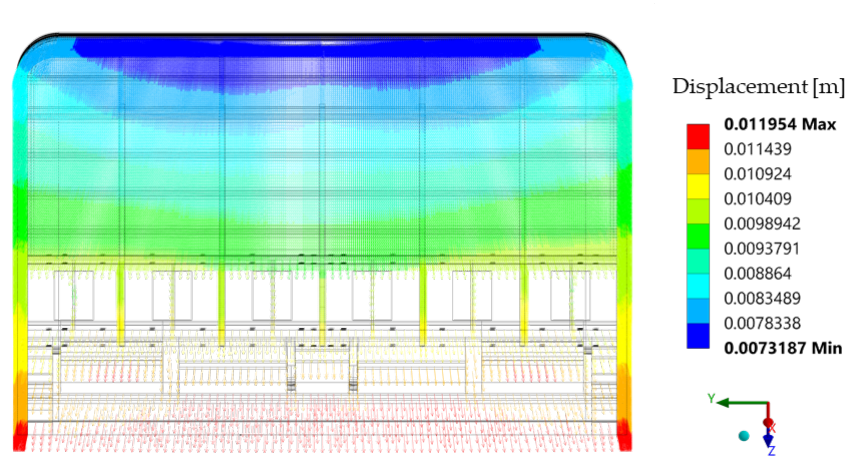
Figure 19. Displacement field mapped onto the TC region lower radial-toroidal boundary